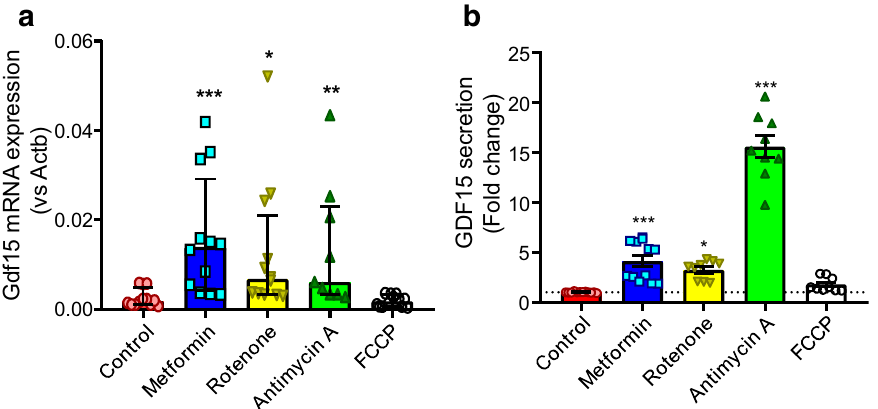
Figure 6. Metformin and mitochondrial electron transport chain inhibitors induce GDF-15 mRNA expression and secretion. ( a ) Gdf15 mRNA expression in mouse duodenal 2D monolayer cultures pre-treated with no treatment control, metformin (1 mM), rotenone (10 µM), antimycin A (10 µM) and FCCP (10 µM) for 24 h (all n = 11–12 wells, 3 wells assessed in parallel from 4 independent experiments). Results presented as median ± Interquartile range. Gdf15 expression normalised relative to Actb . Kruskal–Wallis test and Dunn’s post-hoc test. ( b ) GDF-15 secretion in mouse duodenal 2D monolayer cultures pre-treated with metformin (1 mM, n = 12 wells, 3 wells assessed in parallel from 4 independent experiments), rotenone (10 µM, n = 9 wells, 3 wells assessed in parallel from 3 independent experiments), antimycin A (10 µM, n = 9 wells, 3 wells from 3 independent experiments) and FCCP (10 µM, n = 9 wells, 3 wells from 3 independent experiments) for 24 h. Secretion is normalised to the control (n = 9 wells, 3 wells assessed in parallel from 3 independent experiments). Results presented as mean ± SEM. *P < 0.05, ***P < 0.001. One-way ANOVA and Bonferroni post-hoc